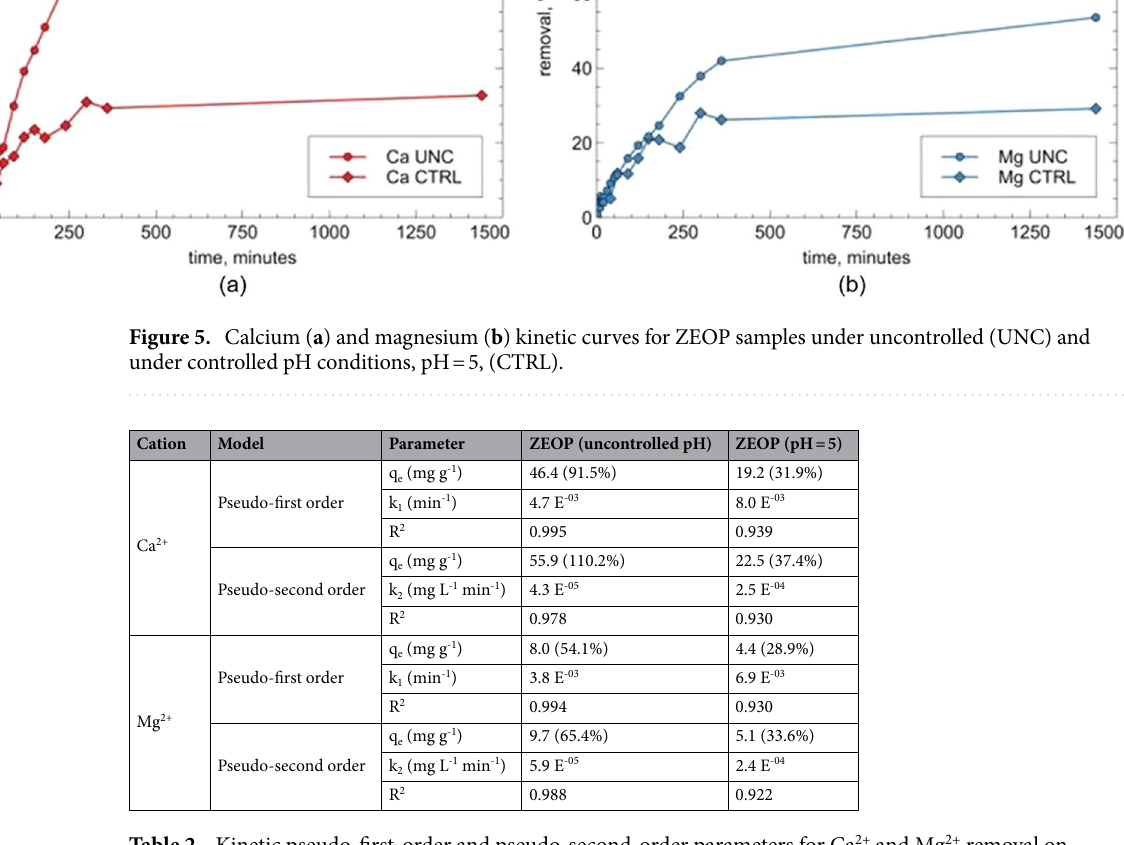
Table 2. Kinetic pseudo-first-order and pseudo-second-order parameters for Ca 2+ and Mg 2+ removal